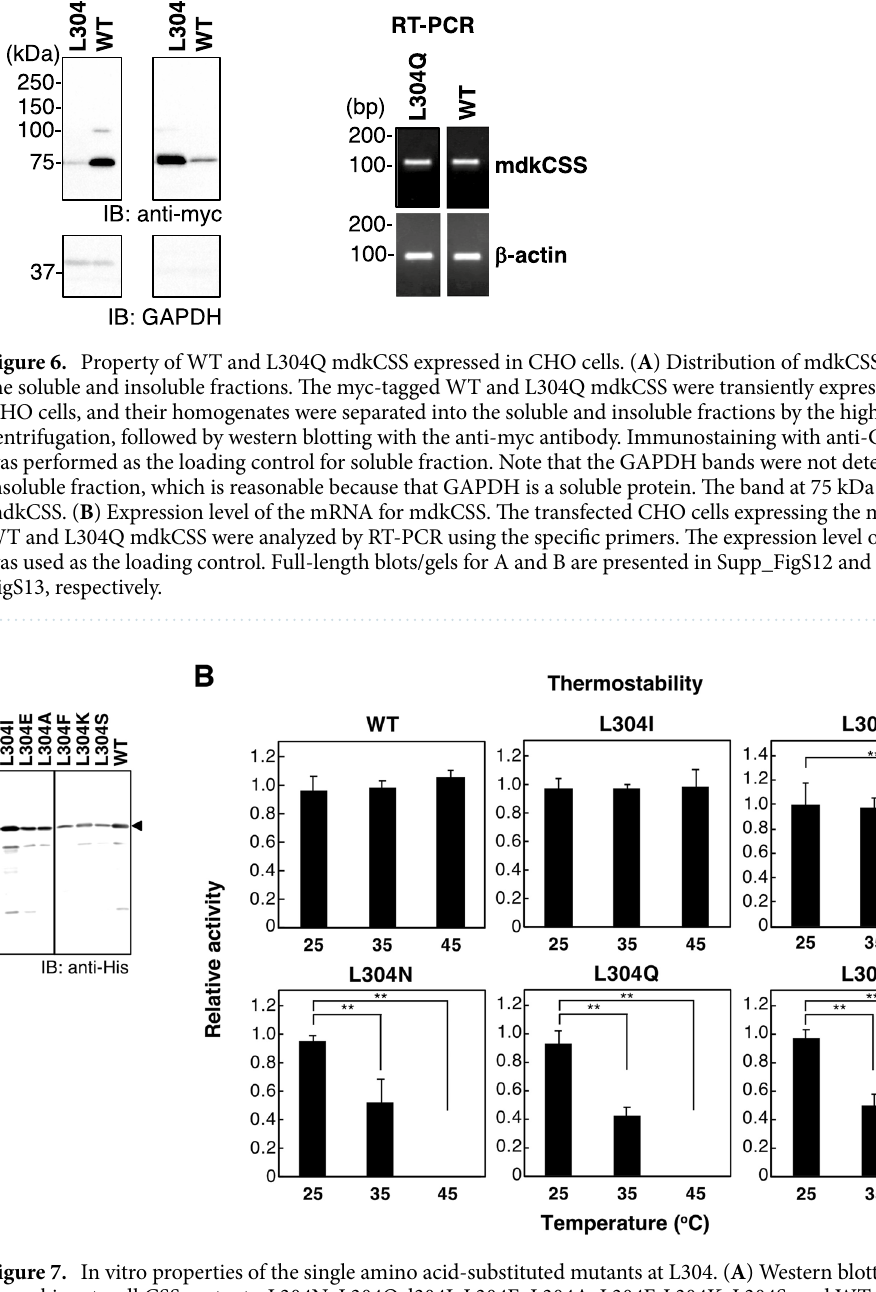
tured cell lines, Chinese hamster ovary (CHO) cells, were purchased from Riken Cell Bank (Koyadai, Japan). Eight weeks-old BALB/c mice were obtained from Japan SLC (Hamamatsu, Japan).